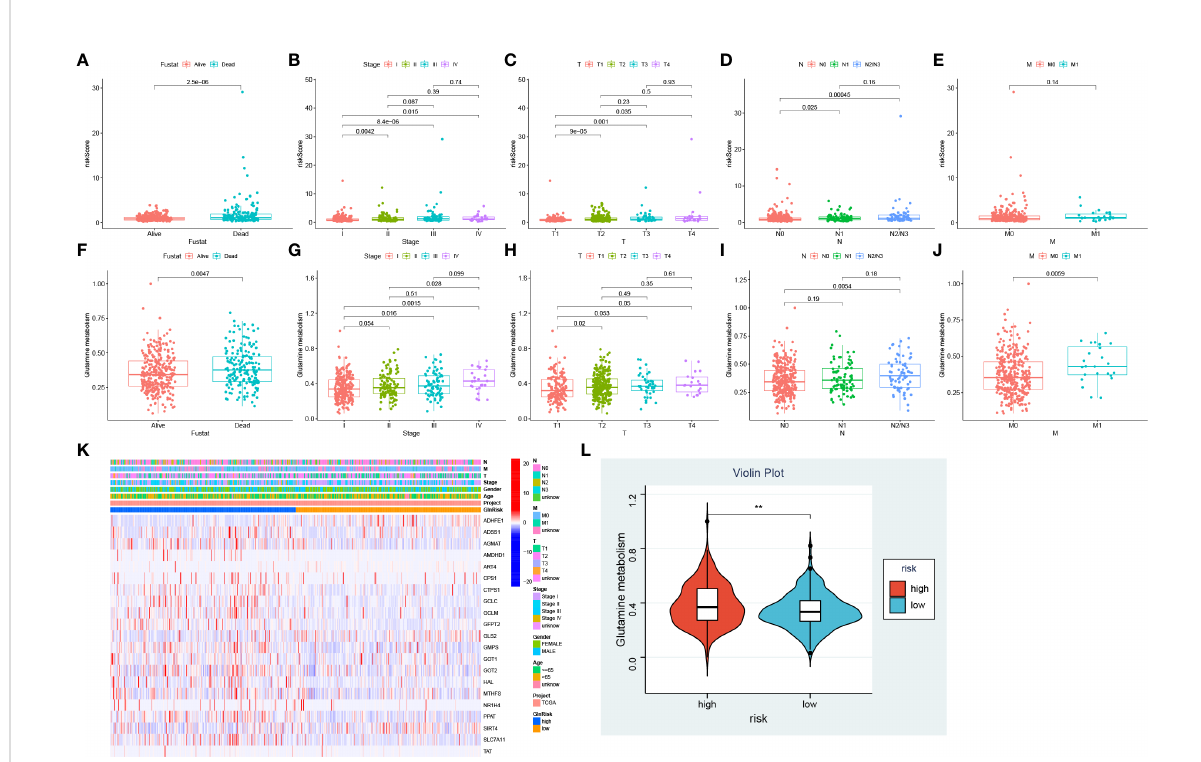
FIGURE 7 Association between Gln metabolism, risk scores and clinical characteristics. Difference of risk score between different survival status (A) , stages (B) , T stages (C) , N stages (D) , and M stages (E) . Level of Gln metabolism in different survival status (F) , stages (G) , T stages (H) , N stages (I) , and M stages (J) . (K) Expression of Gln metabolism regulators between low- and high-risk groups. (L) Difference of Gln metabolism level between low- and high-risk groups. " ** ” means that p <